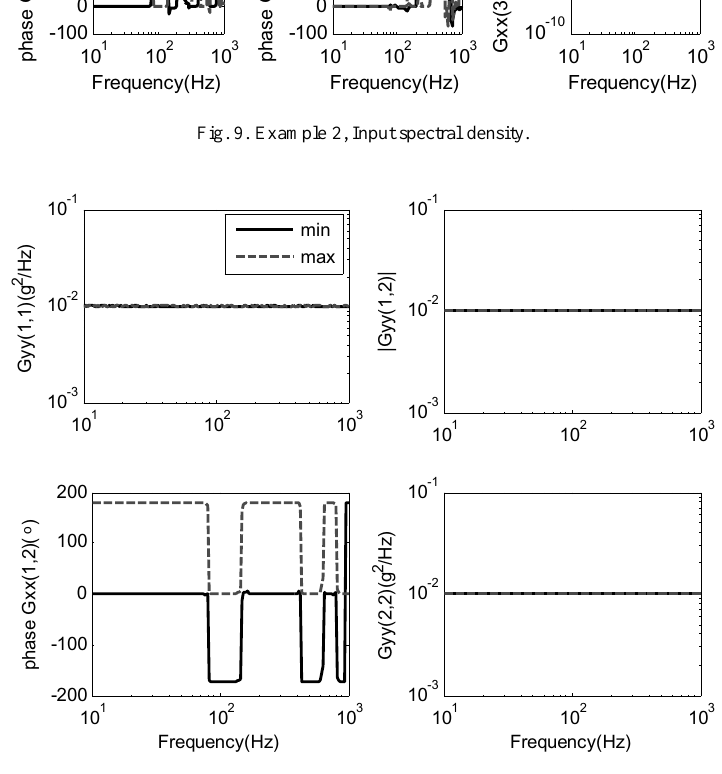
Fig. 10. Example 2, Output spectral